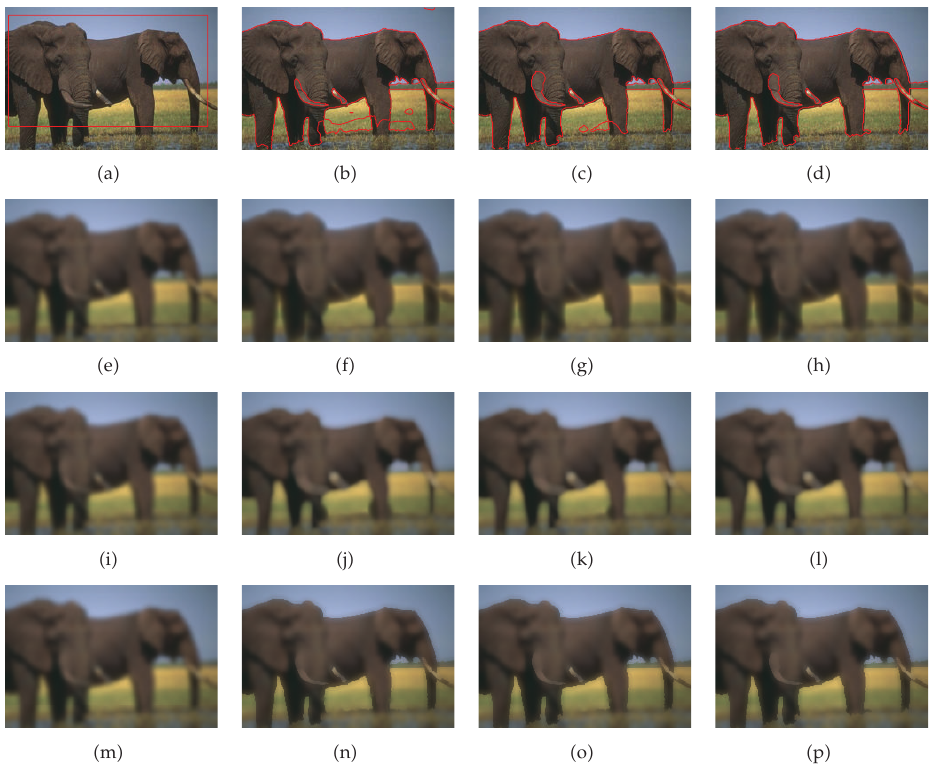
Figure 8: Results of the proposed model for a color image of elephants. (cid:6) a (cid:7) – (cid:6) d (cid:7) show the curve evolution process from the initial contour to the final contour. (cid:6) e (cid:7) – (cid:6) h (cid:7) , (cid:6) i (cid:7) – (cid:6) l (cid:7) , and (cid:6) m (cid:7) – (cid:6) p (cid:7) show f 1 , f 2 and the fitting (cid:26) (cid:6) φ (cid:7) f ff erent iterations. 2 M ε image f (cid:9) i , respectively, at di i (cid:9) 1 i